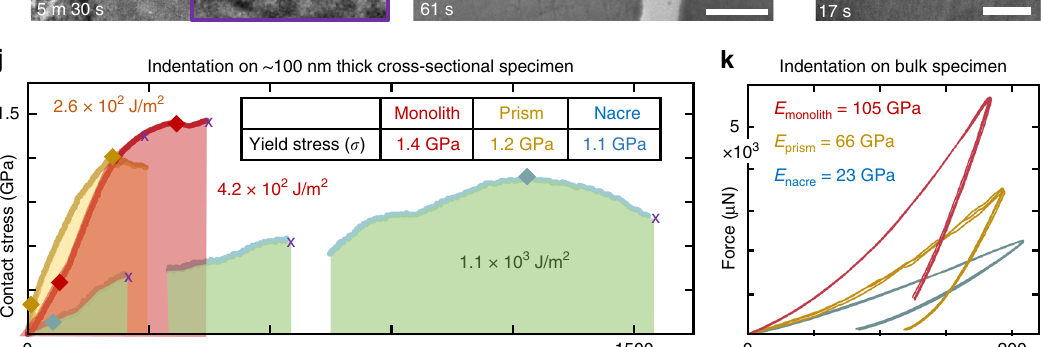
Fig. 4 Toughening processes of nacre, prismatic calcite, and monolithic aragonite. a – c Bright- fi eld TEM images of the cross-sectional nacreous region during in situ TEM indentation. The nacreous tablets made contact on the side of the tip (tip diameter: ~100 nm). Inset in c shows crack blunting at the organic interface. d – f Bright- fi eld TEM images of the cross-sectional prismatic calcite region during indentation. g – i Bright- fi eld TEM images of non- biogenic, monolithic aragonite during indentation. j Correlative compressive contact stress vs. displacement curve showing mechanical response of the nacreous, prismatic, and monolithic region. Stress herein is engineering stress calculated by dividing load by cross-sectional area contacted with tip. Total energy dissipation values (area under contact stress – displacement curves) marked. k Triboindentation on bulk specimens of nacre, prismatic calcite, and monolithic aragonite. Videos provided as Supplementary Material. (See Supplementary Movies 2, 3, and